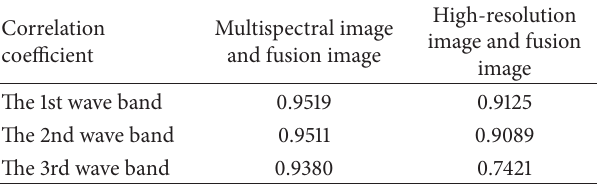
Table 4: Correlation coefficient in this